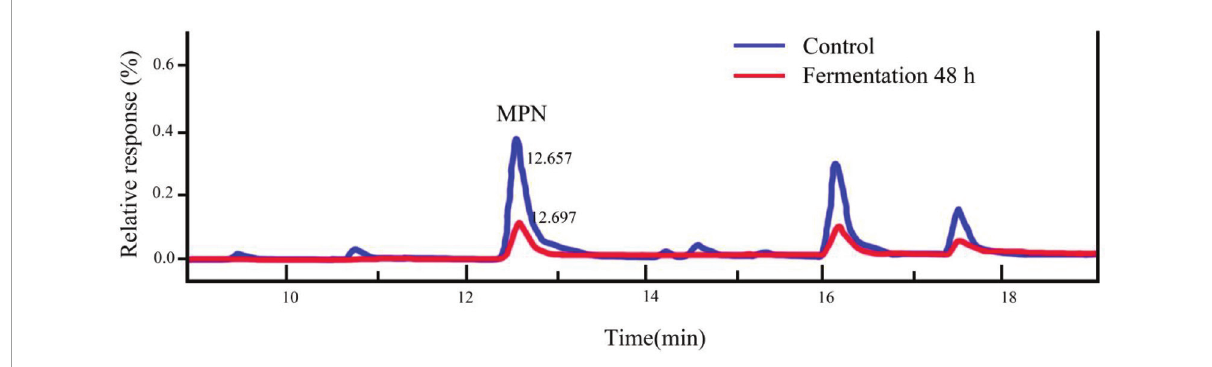
FIGURE5 Changes between fermented and unfermented MPN